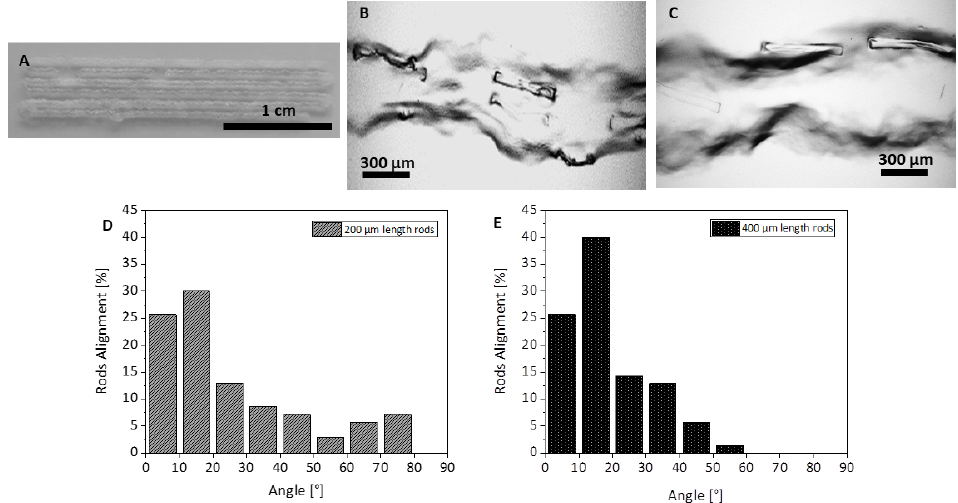
Figure 7. Morphology of the GelMA ink containing rod-shaped fillers extruded using a 3D printer : ( A ) macroscopic view of the parallel filaments, extruded strand containing microrods with ( B ) 200 µm length, and ( C ) 400 µm length. ( D , E ) Quantitative analysis of the aligned microrods in the hydrogel-based ink.